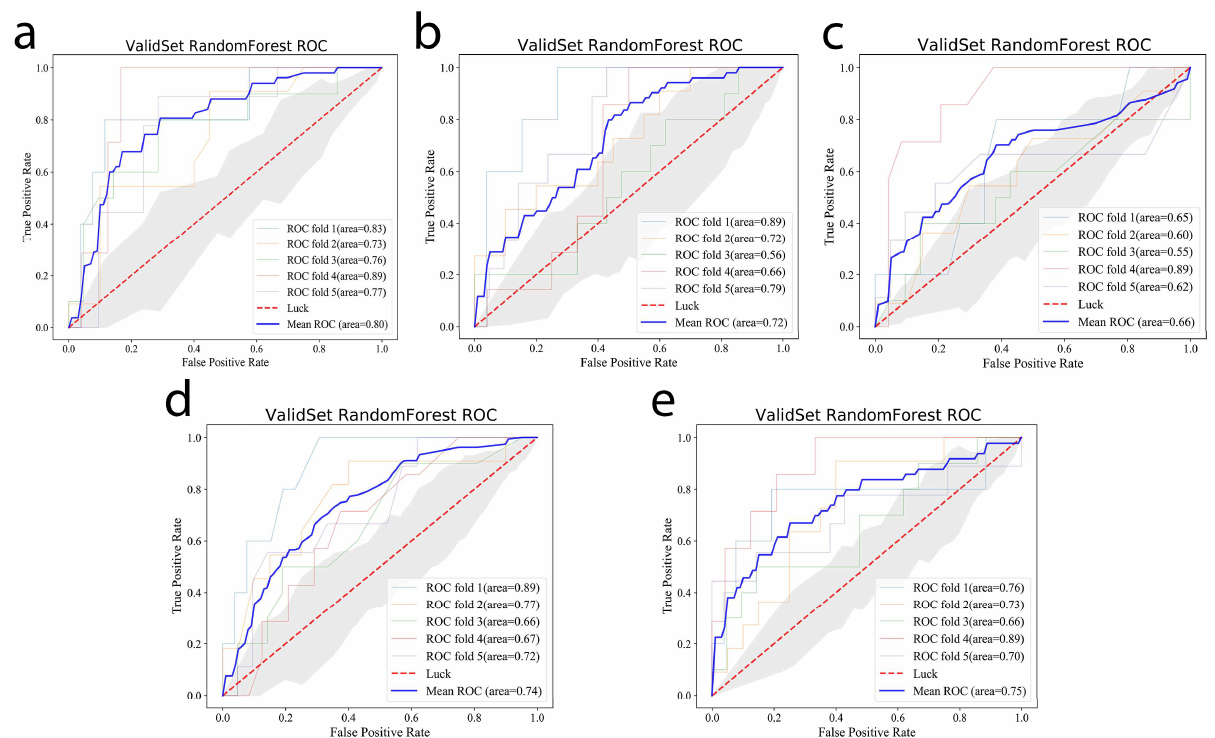
Figure 4. Average AUC values in the validation set of the RF machine learning model based on selected features of model 1 ( a ), model 2 ( b ), model 3 ( c ), model 4 ( d ), and model 5 ( e ).